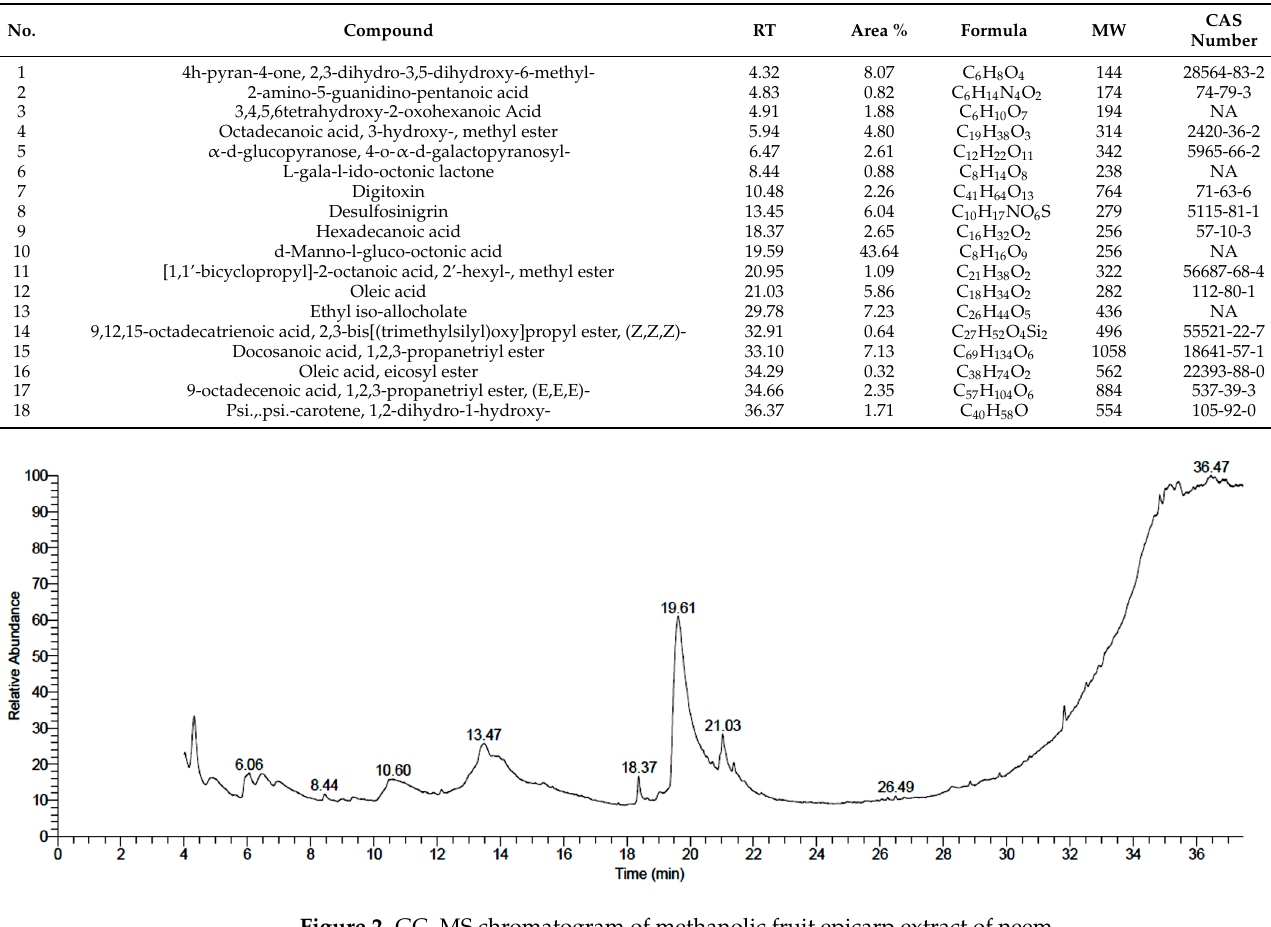
Figure 2. GC–MS chromatogram of methanolic fruit epicarp extract of neem.